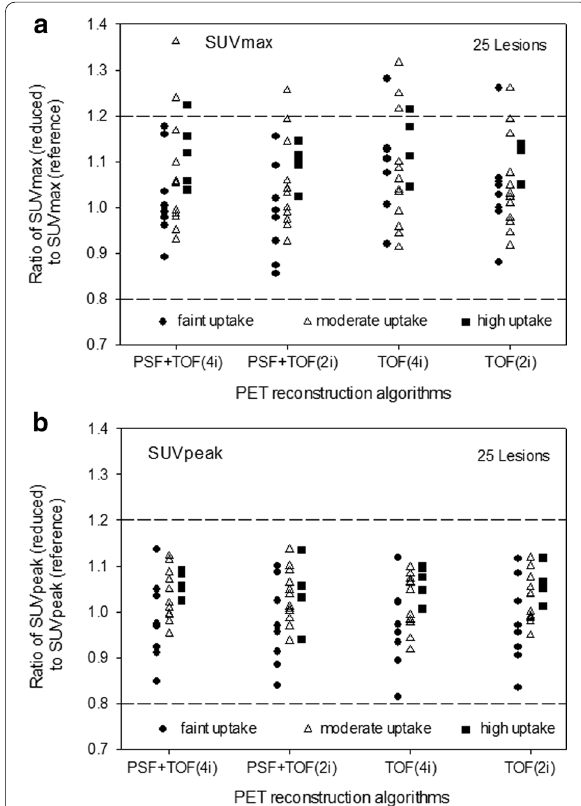
Fig. 3 Dot plots showing the ratio of SUVmax ( a ) and SUVpeak ( b ) between images acquired with reference and reduced scan duration, separately for lesions with faint (filled dots), moderate (white triangles) and intense tracer uptake (filled squares). Margins ( shown in dashed